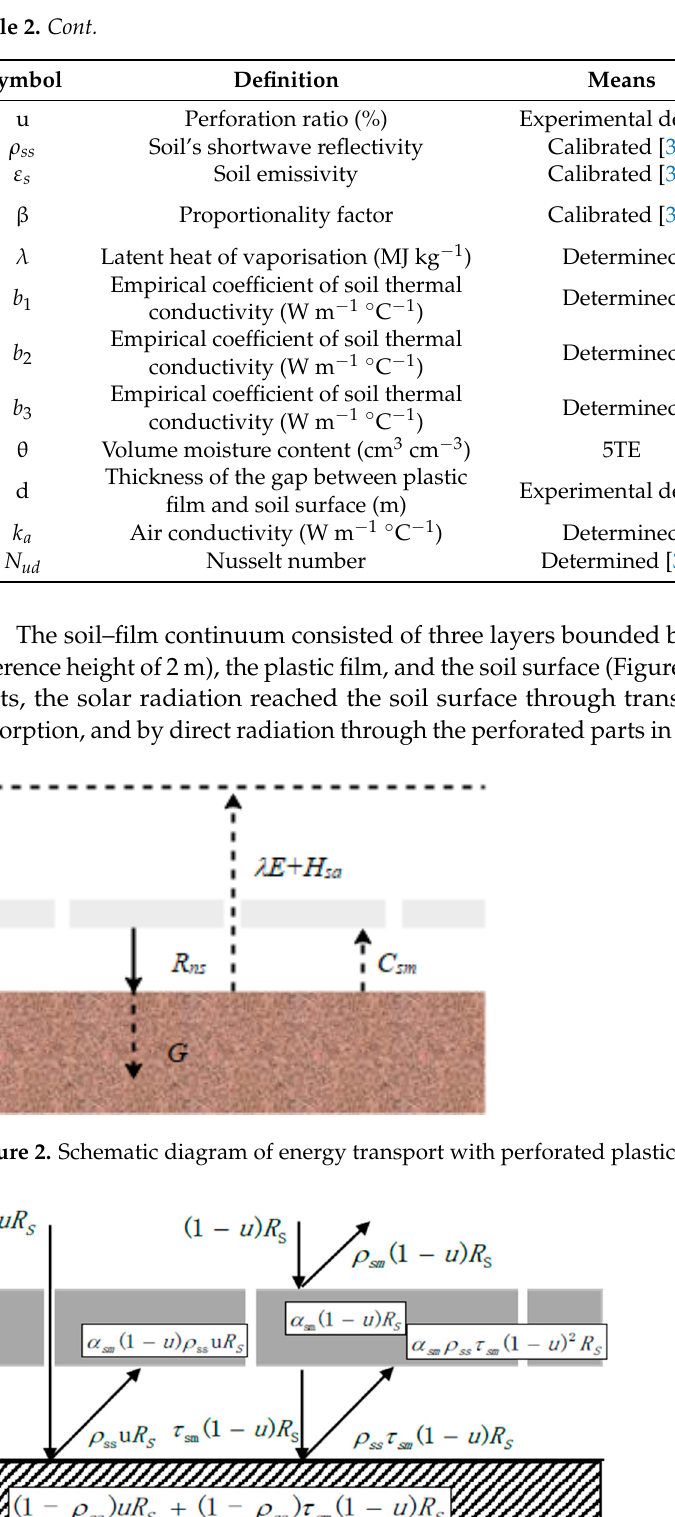
Figure 3. Schematic diagram of shortwave radiation transmission, reflection, and absorption process for the plastic–soil surface vicinity.